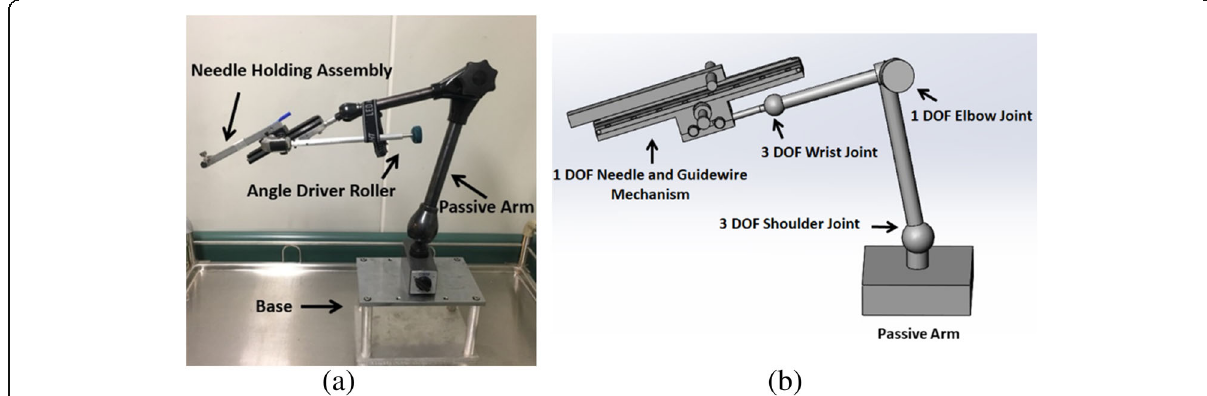
Fig. 1 Passive arm and needle holding assembly. a Seven-degree of freedom (DoF) passive arm with 1-DoF needle holding assembly. Long angle driver roller allows the physician to perform arterial puncturing away from the x-ray source. Base could be easily fixed on the patient bed. b Three-dimensional model of the passive arm and needle holding